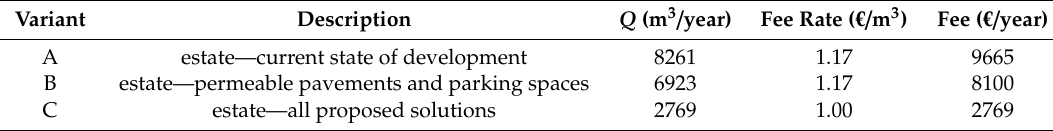
Table 17. Water services fees—fees for rainwater drainage.